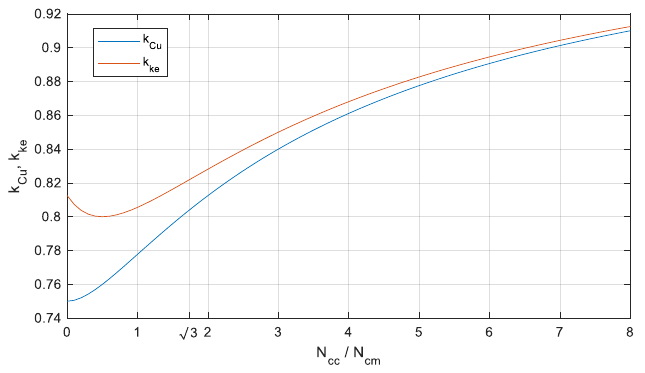
Figure 6. Dependency of coefficients k Cu and k ke on the turns ratio.